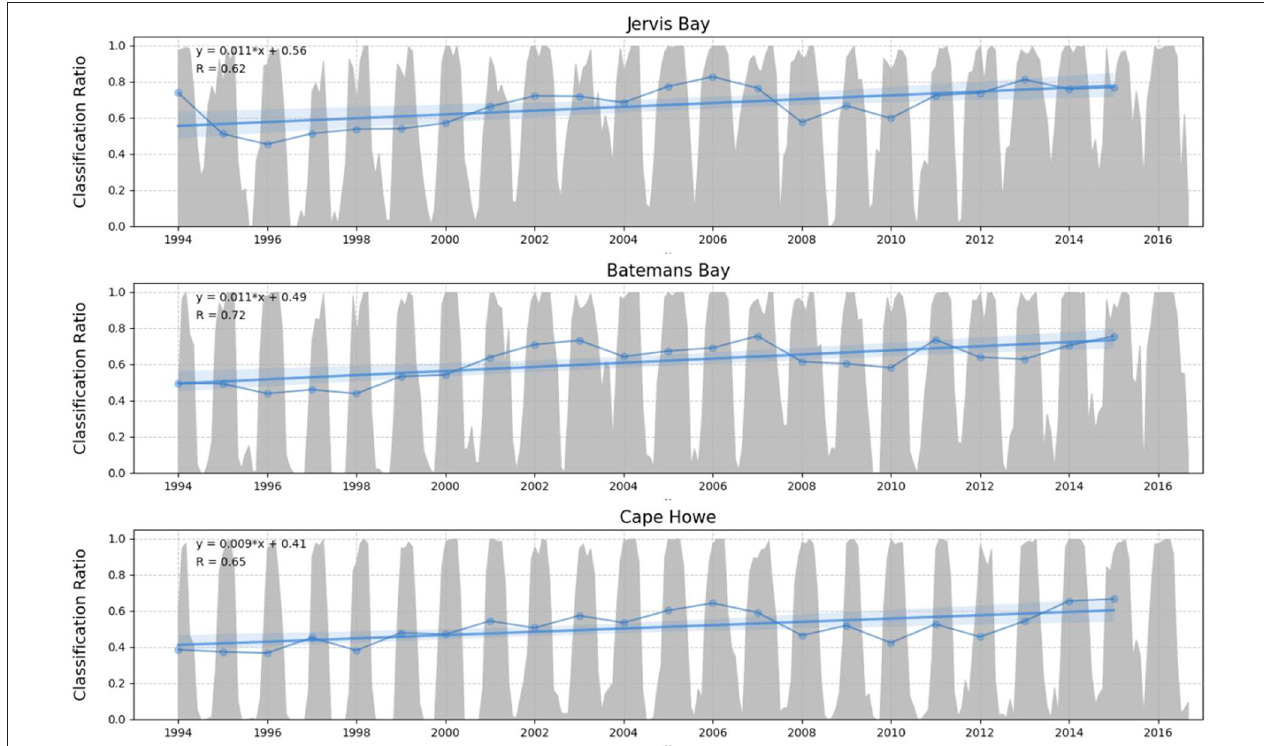
FIGURE 5 | Plot showing the seasonal and inter-annual dynamics of East Australian Current (EAC) presence for each study site over the entire study period (1994–2016). The y-axis depicts the “classification ratio” which is the proportion of a study site’s grid cells that were classified as being of subtropical origin (STO) to those classified as Tasman Sea origin (TSO) derived water. The shaded gray area represents the monthly means of the classification ratio. To investigate the inter-annual trend in EAC dynamics without seasonality, the yearly means are shown as blue points with a linear regression line (with a 95% confidence interval) and associated formula shown in the top left of each panel. The yearly mean for 2016 was excluded from analysis as data does not cover the full